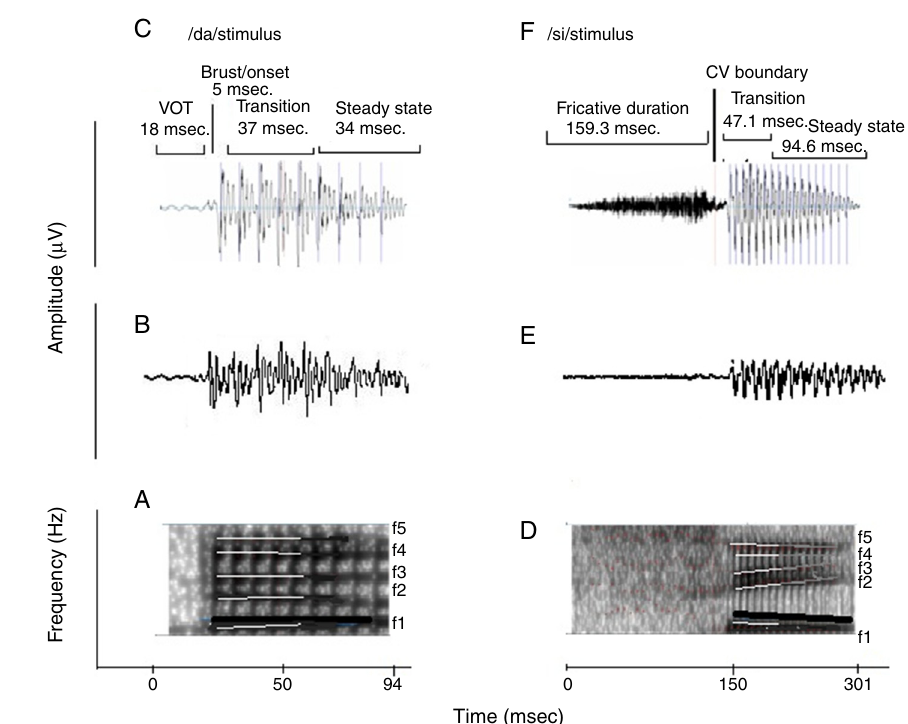
(A) and (D) are the spectrograms of /da/ and /si/ stimuli. The dark black solid line in both stimuli indicates the F 0 , which has a falling pattern. The formant frequencies are represented by white lines. The F 1 and F 2 of /da/ is flat in pattern. The F 1 of /si/ stimulus is falling in pattern and F 2 is raising in pattern. (C) and (F) are the waveforms of /da/ and /si/ stimuli. For sound /da/, the voice onset time was 18 ms, the burst duration was 5 ms, the transition duration was 37 ms and vowel duration of 34 ms. For the sound /si/, the fricative duration was 159.3 ms, transition duration was 47.1 ms and vowel duration was 94.6 ms.